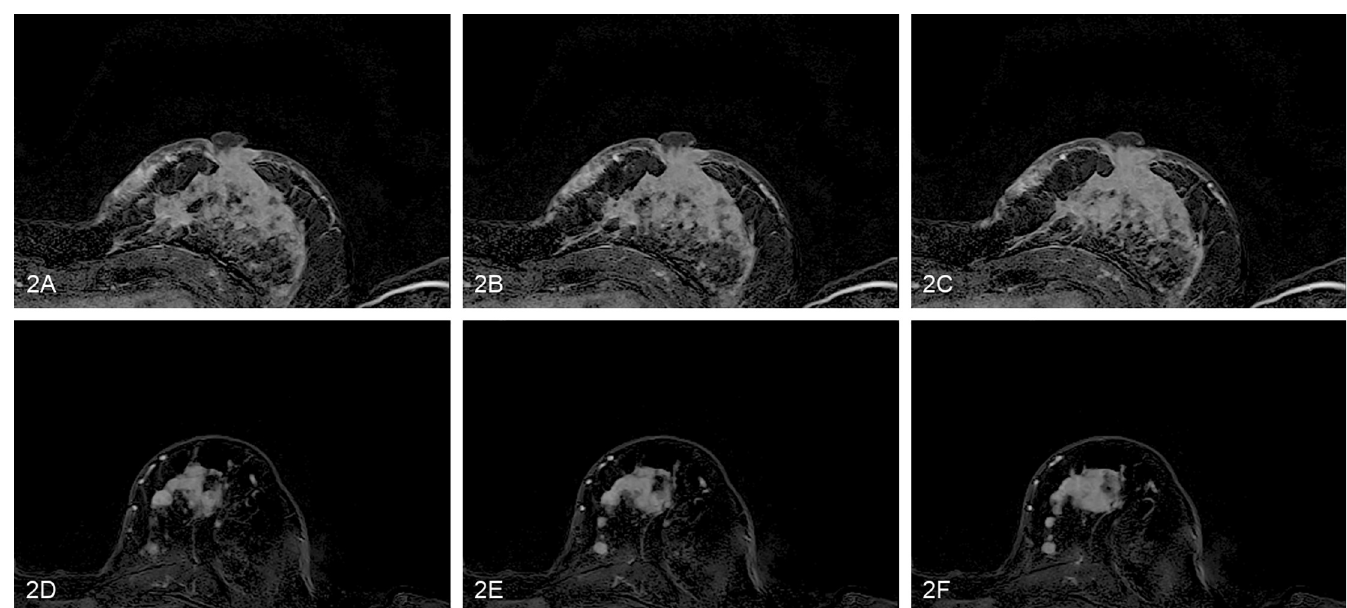
Fig 2. Example of two patients with low and high prediction scores using the model trained to predict low vs high Ki67. (A-C) Three consecutive axial slices of a tumor lesion in the second subtraction series for the patient with the highest prediction score. Histological reference revealed a Ki67 count of 80. (D-F) The corresponding axial slices for the patient with the lowest prediction score. Histological reference revealed a Ki67 count of 10.